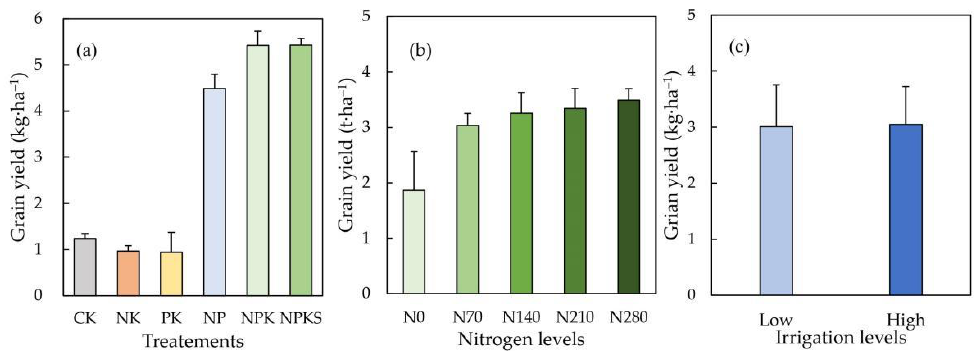
Figure 3. The observed grain yield at varying nutrient treatments: ( a ) NBES plots, WNCR plots across various ( b ) nitrogen and ( c ) irrigation